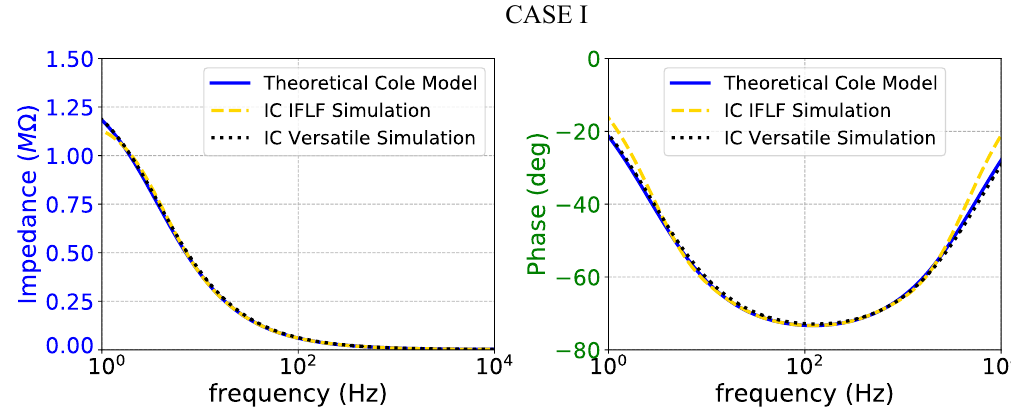
Figure 23. Impedance magnitude ( left ) and phase response ( right ) of the case I fractional-order skin model.